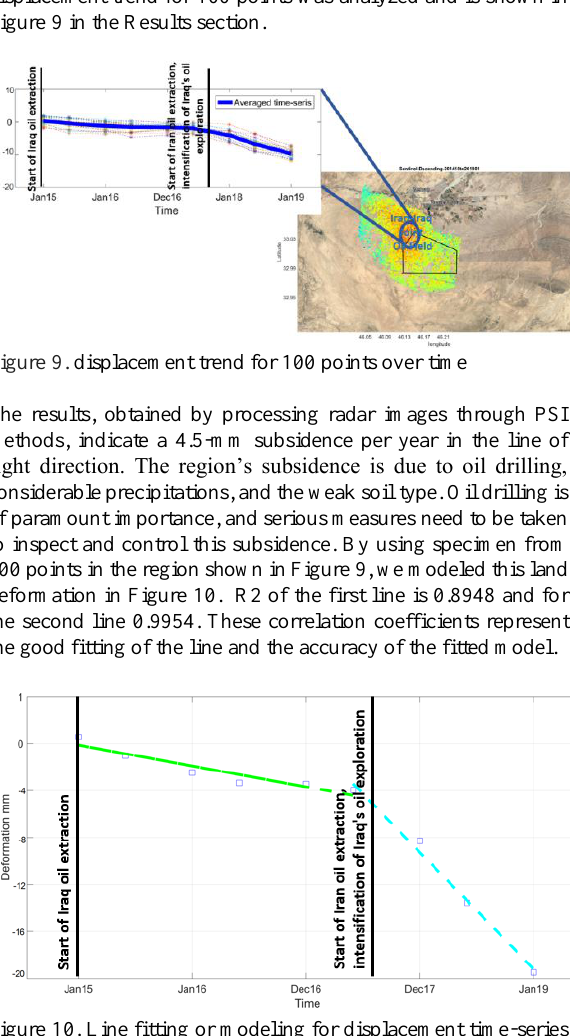
Figure 10. Line fitting or modeling for displacement time-series in Azar